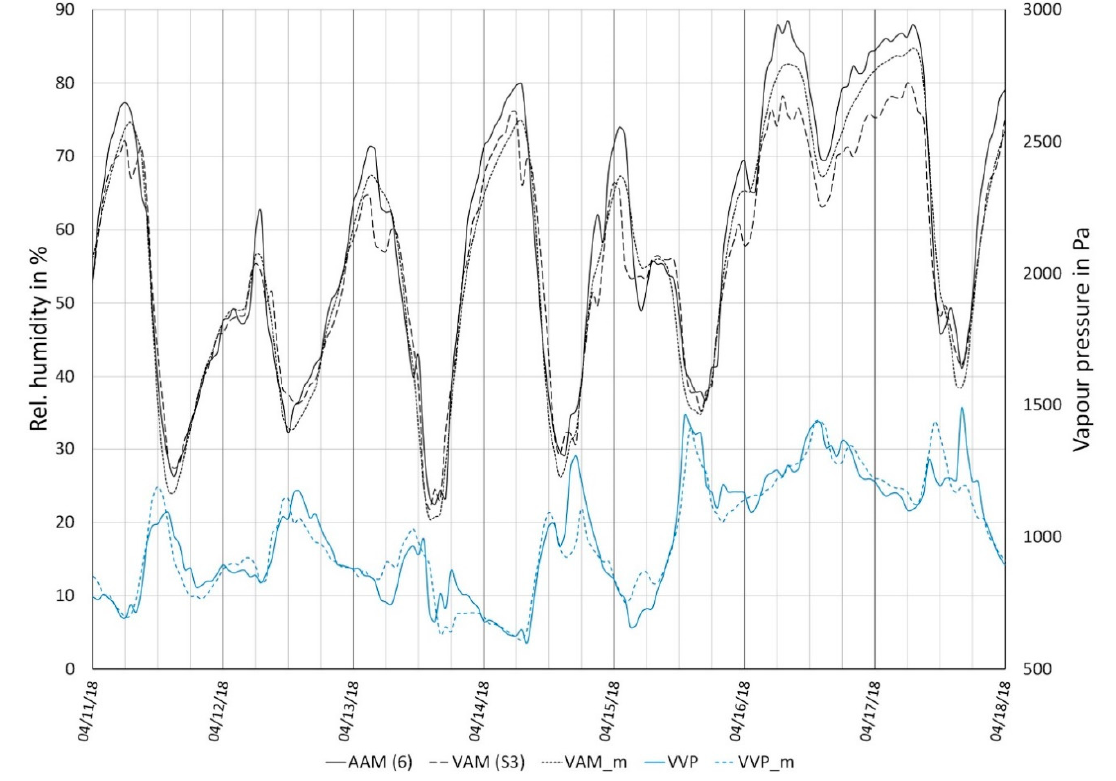
Figure 4. Air moisture content in mid-April 2018.